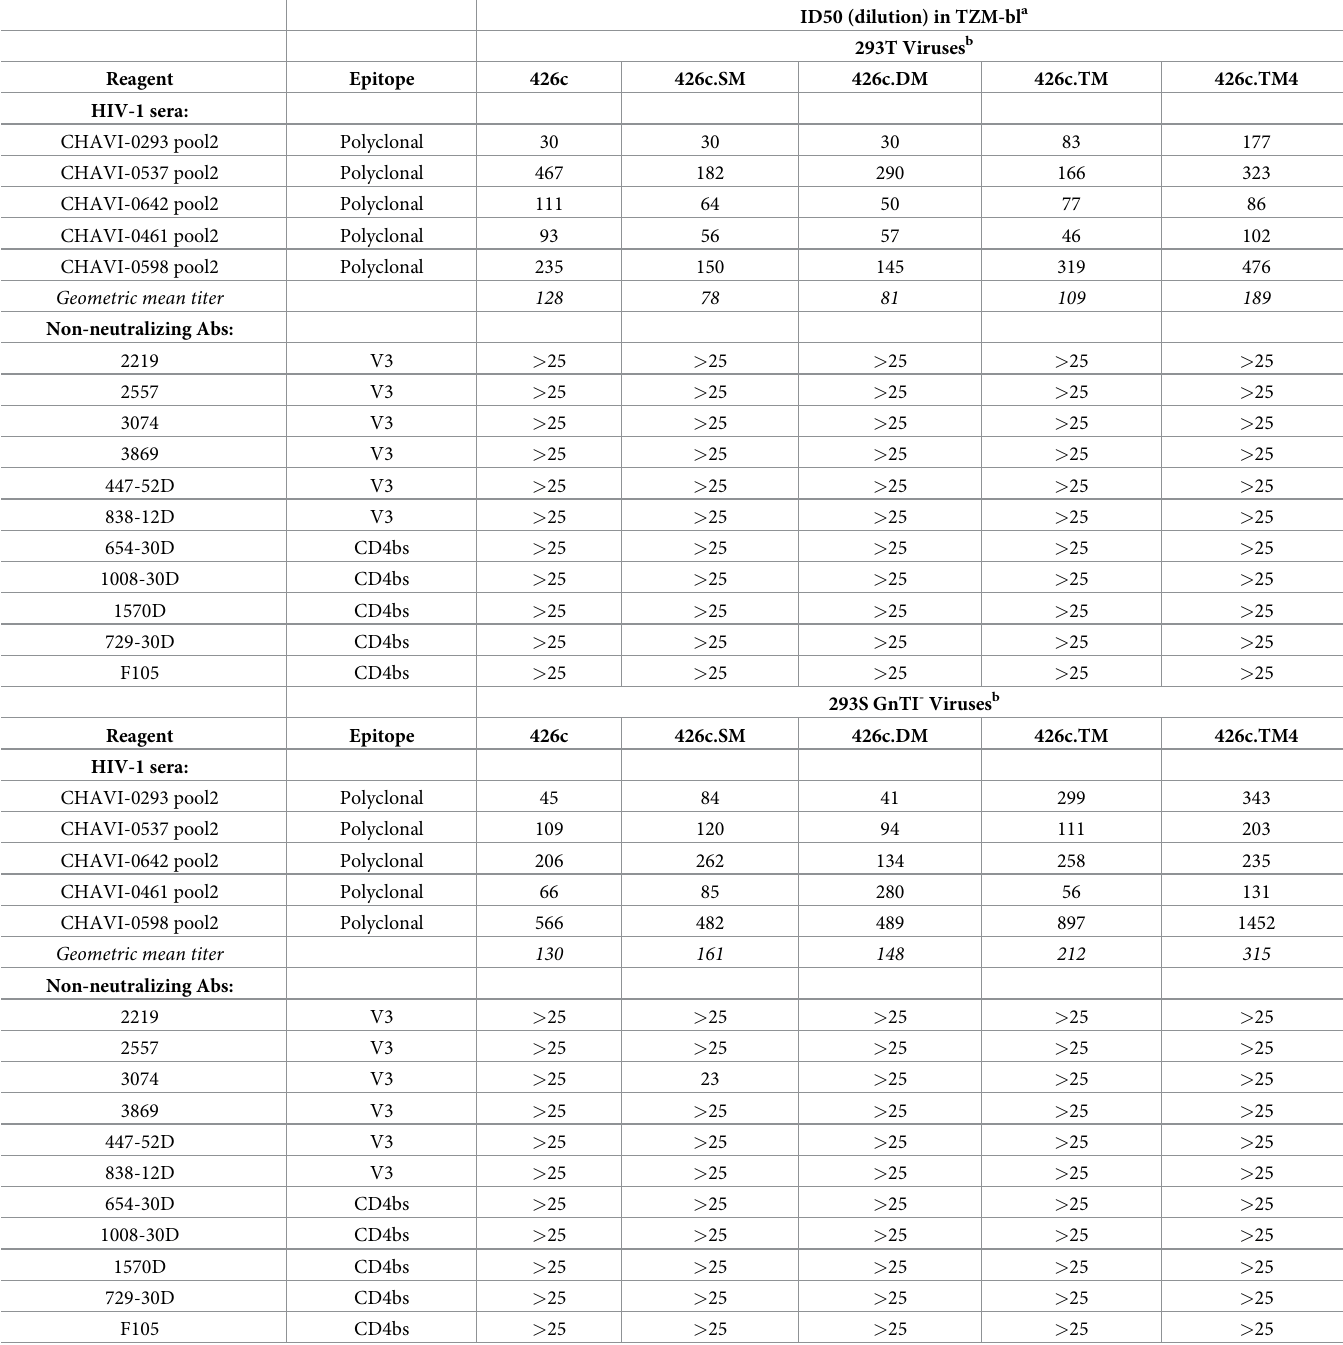
Table 3. HIV-1 426c variants produced in GnT1 - cells retain a tier 2 neutralization